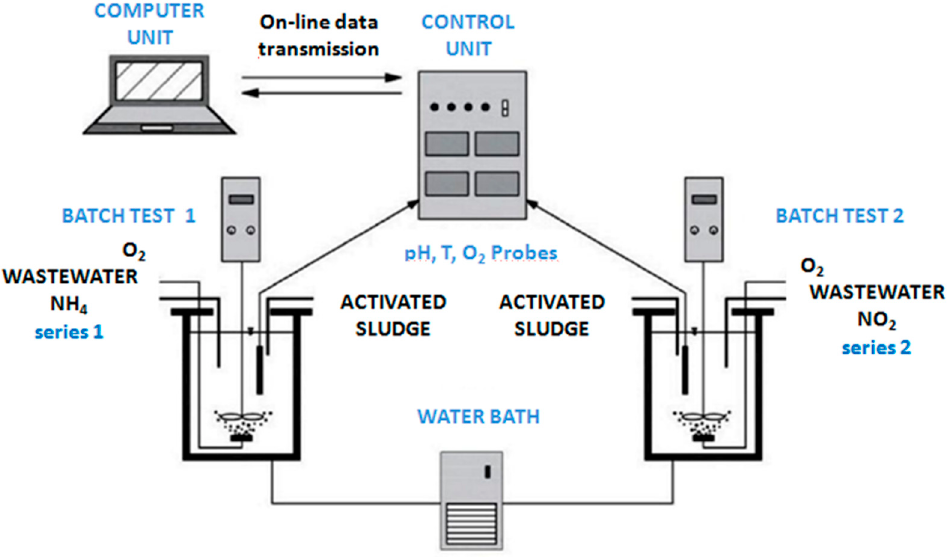
Figure 1. Scheme of the laboratory installation used in the experiment.